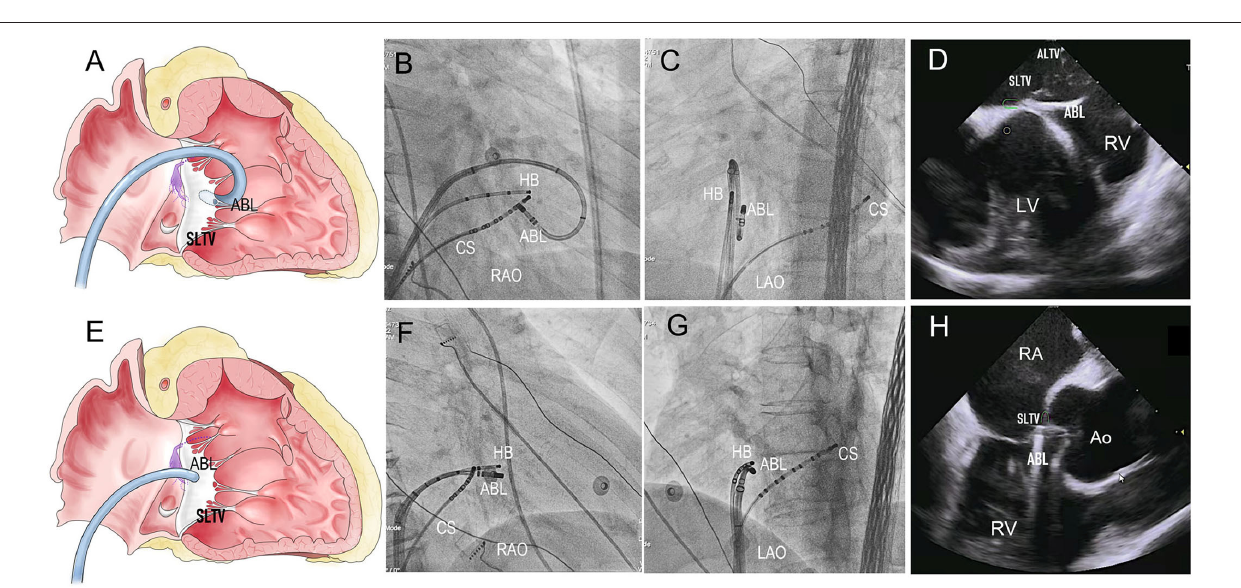
FIGURE 2 | The Catheter placement in the B-SLTV and A-SLTV approach. (A) The schematic diagram illustrating the catheter tip was reversely curved beneath the SLTV (RAO view). (B,C) The fluoroscopic images showing the catheter was reversely curved beneath the SLTV through a long sheath (RAO and LAO view). (D,H) The ultrasonic images confirmed the catheter placement beneath the SLTV. (E) The schematic diagram showing the catheter tip was directly placed above the SLTV (RAO view). (F,G) The fluoroscopic images showing the catheter tip was placed directly above the SLTV (RAO and LAO view). HB, the His bundle; CS, coronary sinus; ABL, the ablation catheter; SLTV, the septal leaflet of the tricuspid valve; ALTV, the anterior leaflet of the tricuspid valve; RA, the right atrium; RV, the right ventricle; LV, left ventricle; RAO, right anterior oblique; LAO, left anterior